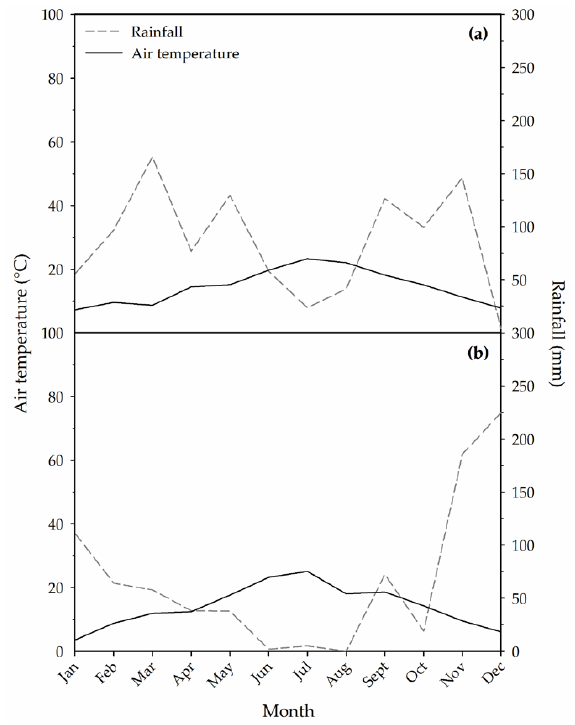
Figure 1. Walter climate diagram reporting monthly mean air temperatures and total rainfall recorded in 2016 ( a ) and 2017 ( b ).